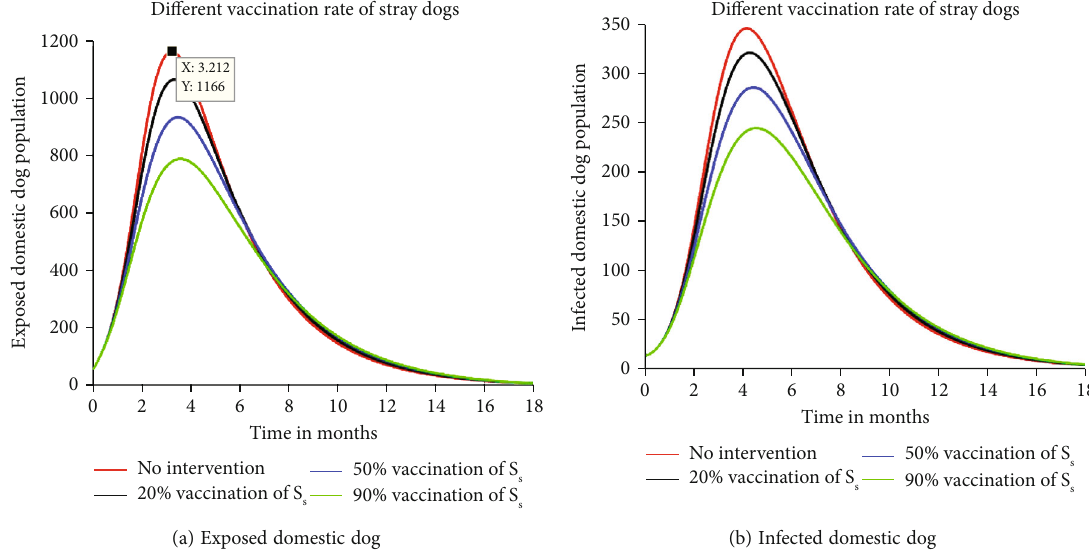
Figure 5: The e ff ect of stray dog ’ s vaccination ( parameter θ